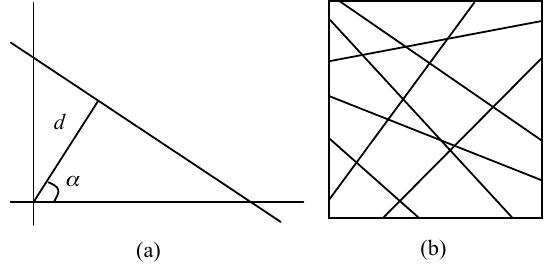
Fig.2 Plane linear expression (a), Poisson Division